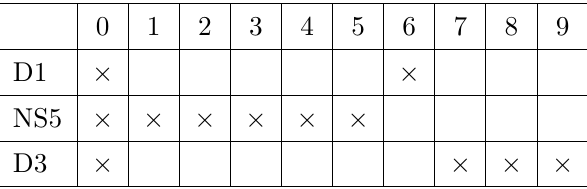
Table 1 . The 1 -BPS intersection involving D1, D3 and NS5 branes. A supersymmetric quantum 4 mechanics lives in the common x 0 direction. The corresponding SO(5) R (cid:2) SO(3) R R-symmetry is geometrically realised as rotations in the ( x 1 ; : : : ; x 5 ) and ( x 7 ; x 8 ; x 9 ) coordinates, respectively.